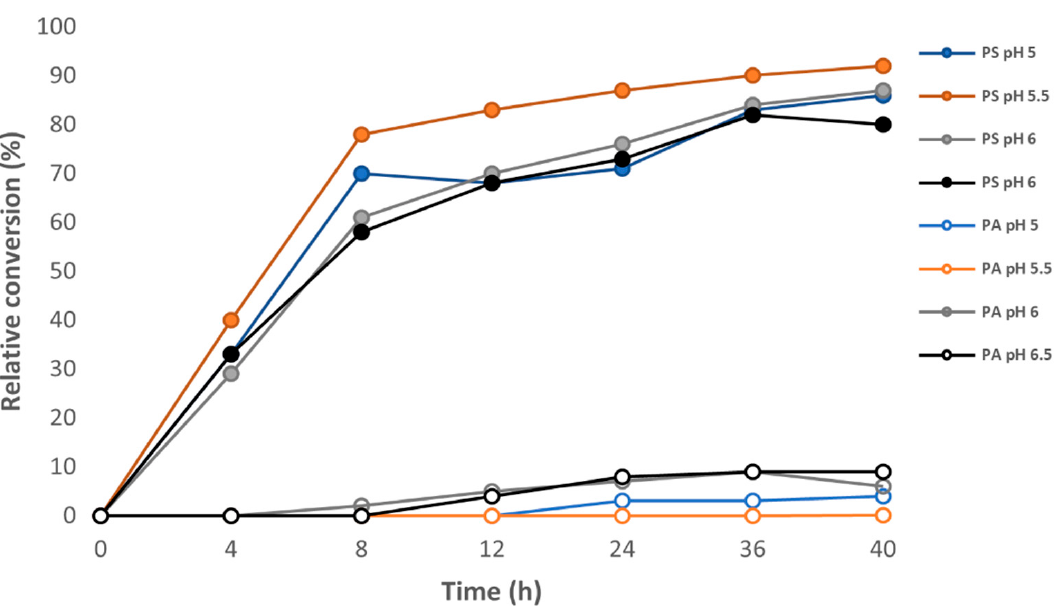
Figure 2. Effect of pH on the formation of phosphatidylserine (PS) from high-phosphatidylcholine soy lecithin. Reaction conditions: 6 mL of 0.2 M acetate buffer containing 2.5 M L-serine, 0.01 M CaCl 2 , 25 mL ethyl acetate, 0.3 g of soy lecithin, 8 units phospholipase D, T = 37 °C. PS— phosphatidylserine (solid symbols), PA—phosphatidic acid (open symbols). Error bars lie within the data points.